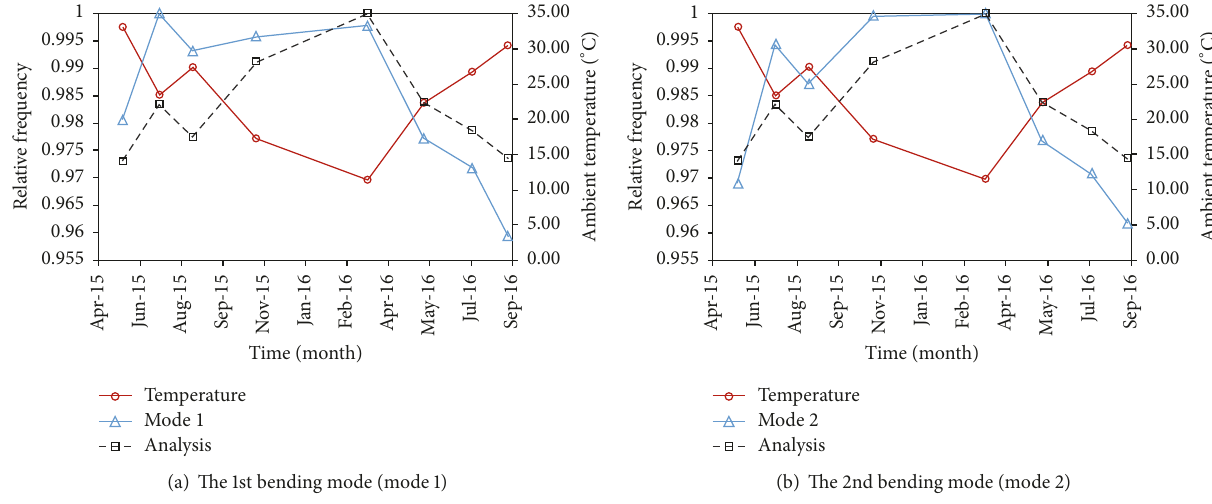
Figure 25: ((a)-(b)) Variations in two bending modal frequencies of girder No. 1 over one and a half years.